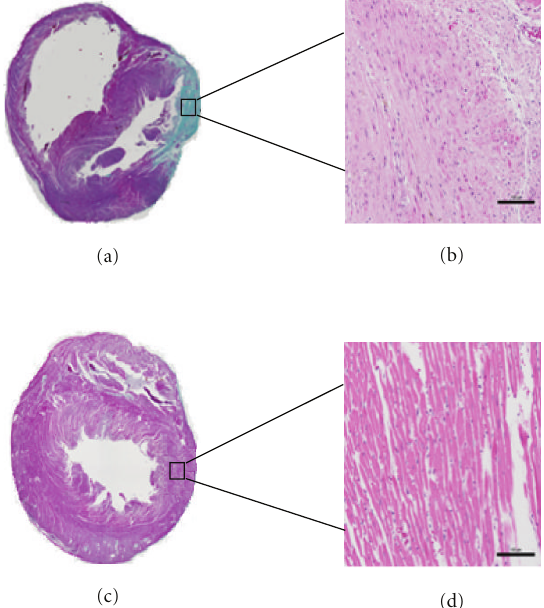
Figure 4: Comparison of histological images 4 weeks after surgery for an MI rat ((a), (b)) and a sham rat ((c), (d)). (a) Myocardial tissue slice of MI rat-blue stain corresponds to the infarcted area in the anterior and lateral regions of the heart. Significant wall thinning is evident in infarcted areas. (b) Hematoxylin-eosin-stained slice from an infarcted rat × 10 magnification (scale bar = 100 μ m). Loss of myocytes is evident in the infarcted area which is rich with atypical nuclei. (c) Myocardial tissue slice of a sham rat. Absence of blue stain confirms that LAD ligation caused myocardial infarction in infarcted rats. (d) Hematoxylin-eosin-stained slice from a sham rat × 10 magnification (scale bar = 100 μ m). Appropriate alignment and no loss of myocytes indicate absence of